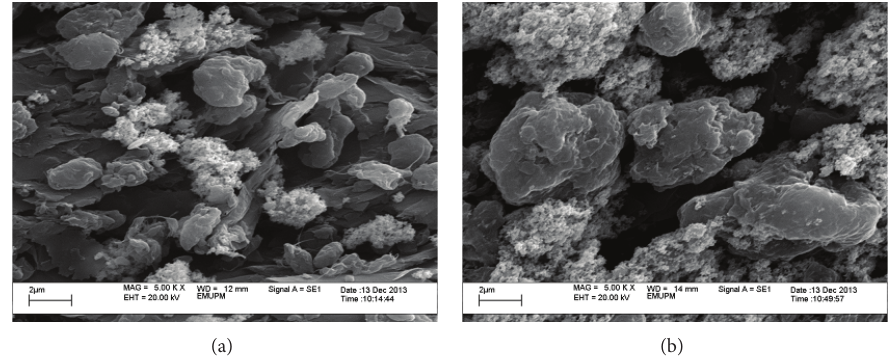
Figure 1: Variable pressure scanning electron microscopy (VPSEM) images of SWCNT/Ni composites on a basal plane pyrolytic graphite electrode (BPPGE, 5 mm diameter) surface (a) before and (b) after the electroanalysis.